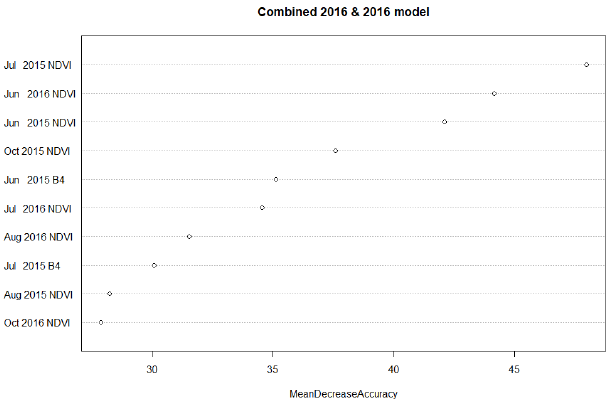
Figure 5. Variable importance reported as mean decrease in accu- racy. The 10 most important variables are shown, with B1 and B4 corresponding to spectral bands 1 and 4, respectively, from Pleiades image. Variable importance is determined by the model output as the decrease in accuracy due to the exclusion of that variable during the out-of-bag error calculation process. Higher mean decrease in accuracy variables is more important in classifying the data.